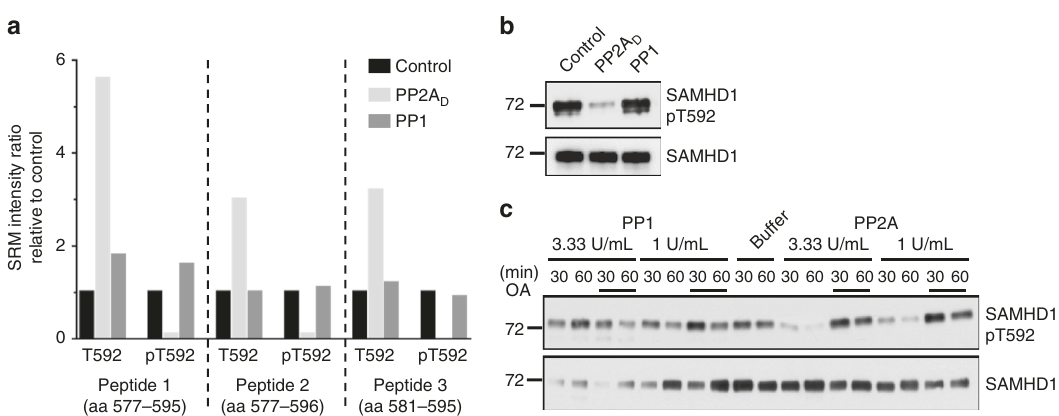
Fig. 3 PP2A, not PP1, is able to dephosphorylate SAMHD1 pT592 in vitro. a Targeted nano-LC-MS/MS analysis reveals PP2A as responsible phosphatase acting on SAMHD1 pT592. 1 µ g of recombinant SAMHD1 was incubated with equilibrated units of PP2A D and PP1, or buffer alone (control) for 1 h at 30 °C. After stopping the reaction by addition of 5 × SDS-PAGE sample buffer, the 1D-gel piece containing SAMHD1 was subjected to trypsin digestion followed by targeted nano-LC-MS/MS of the resulting peptides. Relative quanti fi cation of phosphorylated and non-phosphorylated peptides encompassing T592 in different conditions (treatment with PP2A D or PP1 compared to buffer only (control)) is displayed by means of their SRM intensity ratios. b Validation of MS data by immunoblot analysis with anti-SAMHD1 pT592 antibodies, executed on the same samples as described in Fig. 3a. The data are representative of three independent experiments. c Time- and concentration-dependency of SAMHD1 pT592 dephosphorylation by PP2A D . In vitro-dephosphorylation of recombinant SAMHD1 was executed with the indicated units of PP1 or PP2A D for the indicated time points. When appropriate, 50 nM OA was added to the phosphatases in a 10 min-pre-incubation step, before addition of the substrate, and dephosphorylation for the indicated times. SAMHD1 (de) phosphorylation was monitored by immunoblotting of samples with SAMHD1 pT592-speci fi c